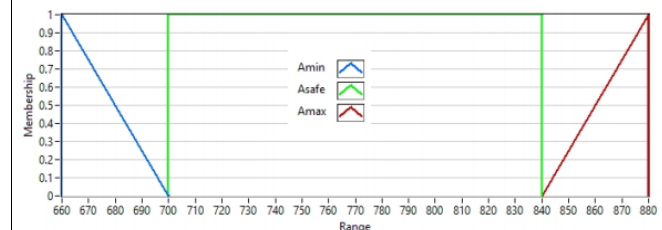
Figure 10: Graph of member functions of Potentiometer A.